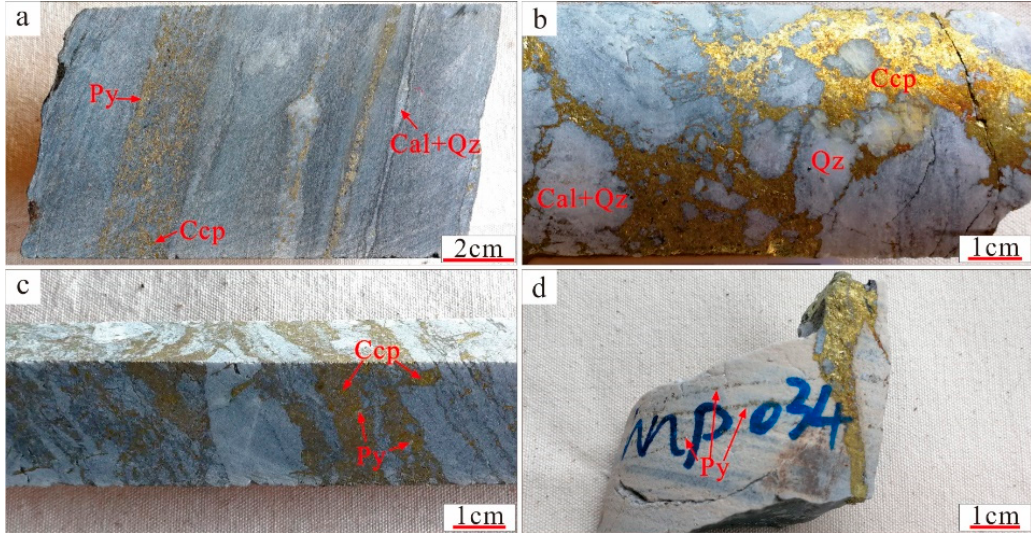
Figure 4. Photographs of representative ore hand specimens. ( a ) Laminated ore with sulfides parallel to the foliation; ( b ) vein-type ore showing quartz-calcite- sulfide veins filling the fractures of the host rock; ( c ) early laminated ore overprinted by late sulfide veins; ( d ) early laminated ore cut by late chalcopyrite vein. Mineral abbreviations: Py, pyrite; Ccp, chalcopyrite; Cal, calcite; Qz, quartz.